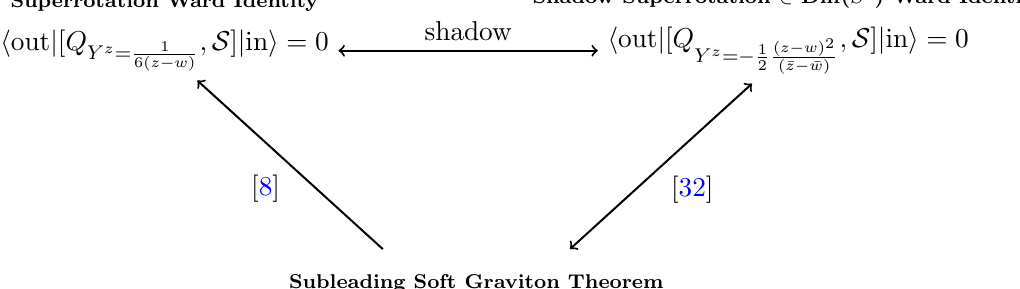
Figure 1. Superrotations imply the subleading soft graviton theorem so long as the asymptotic Virasoro symmetry group is enhanced to include shadow